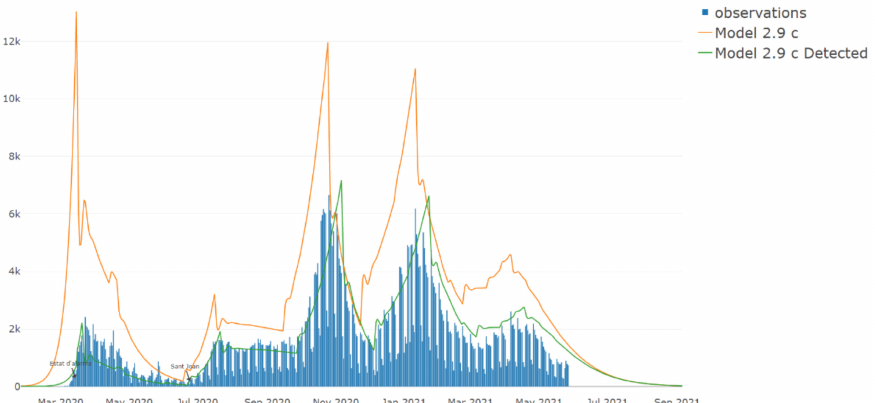
Figure 9. Model 2.9 now forecasts for new cases ( y -axis) the end of the pandemic situation in Catalonia if the NPIs remain similar to the current (at 05 June 2021) and no new variants appear.